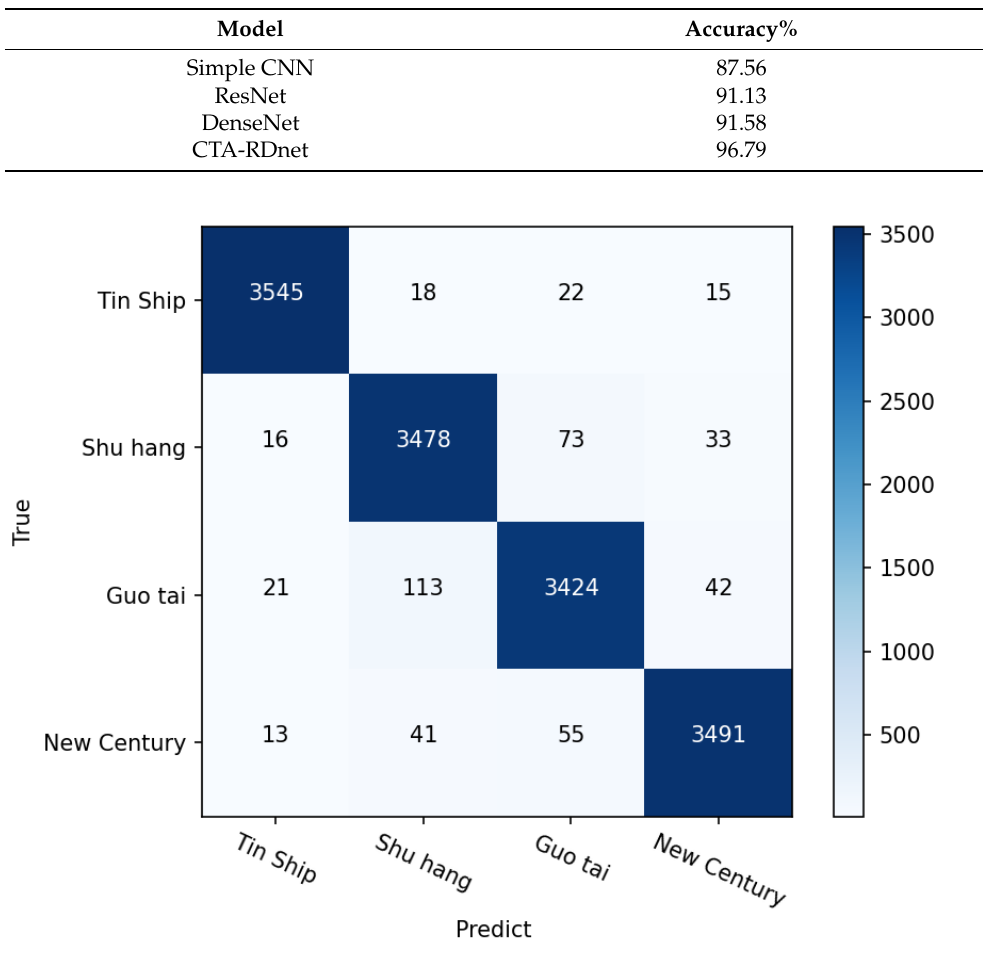
Figure 11. The ROC curve of the CTA-RDnet. Table 4. Experimental results of different models. Model